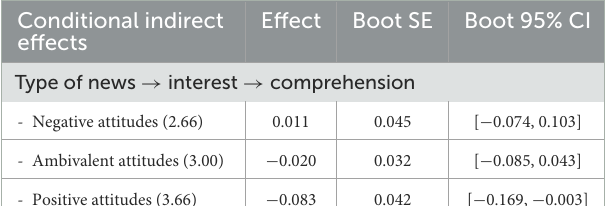
TABLE 2 Conditional indirect